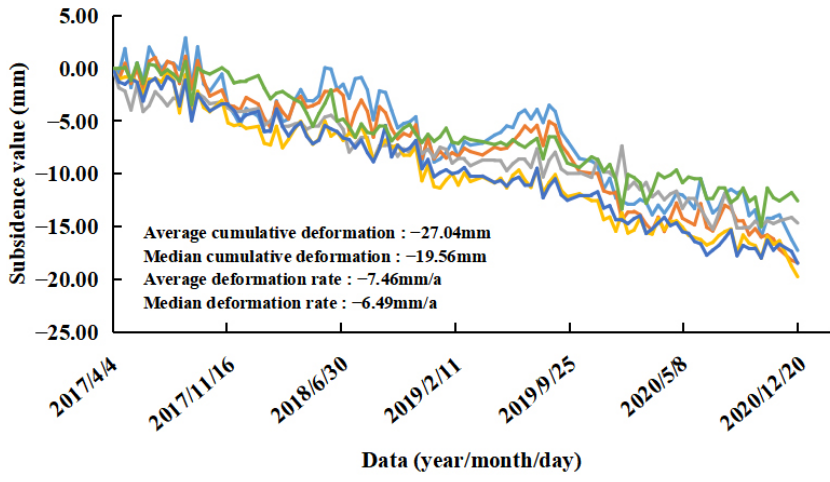
Figure 13. Deformation rate of a logistics company in Area B.